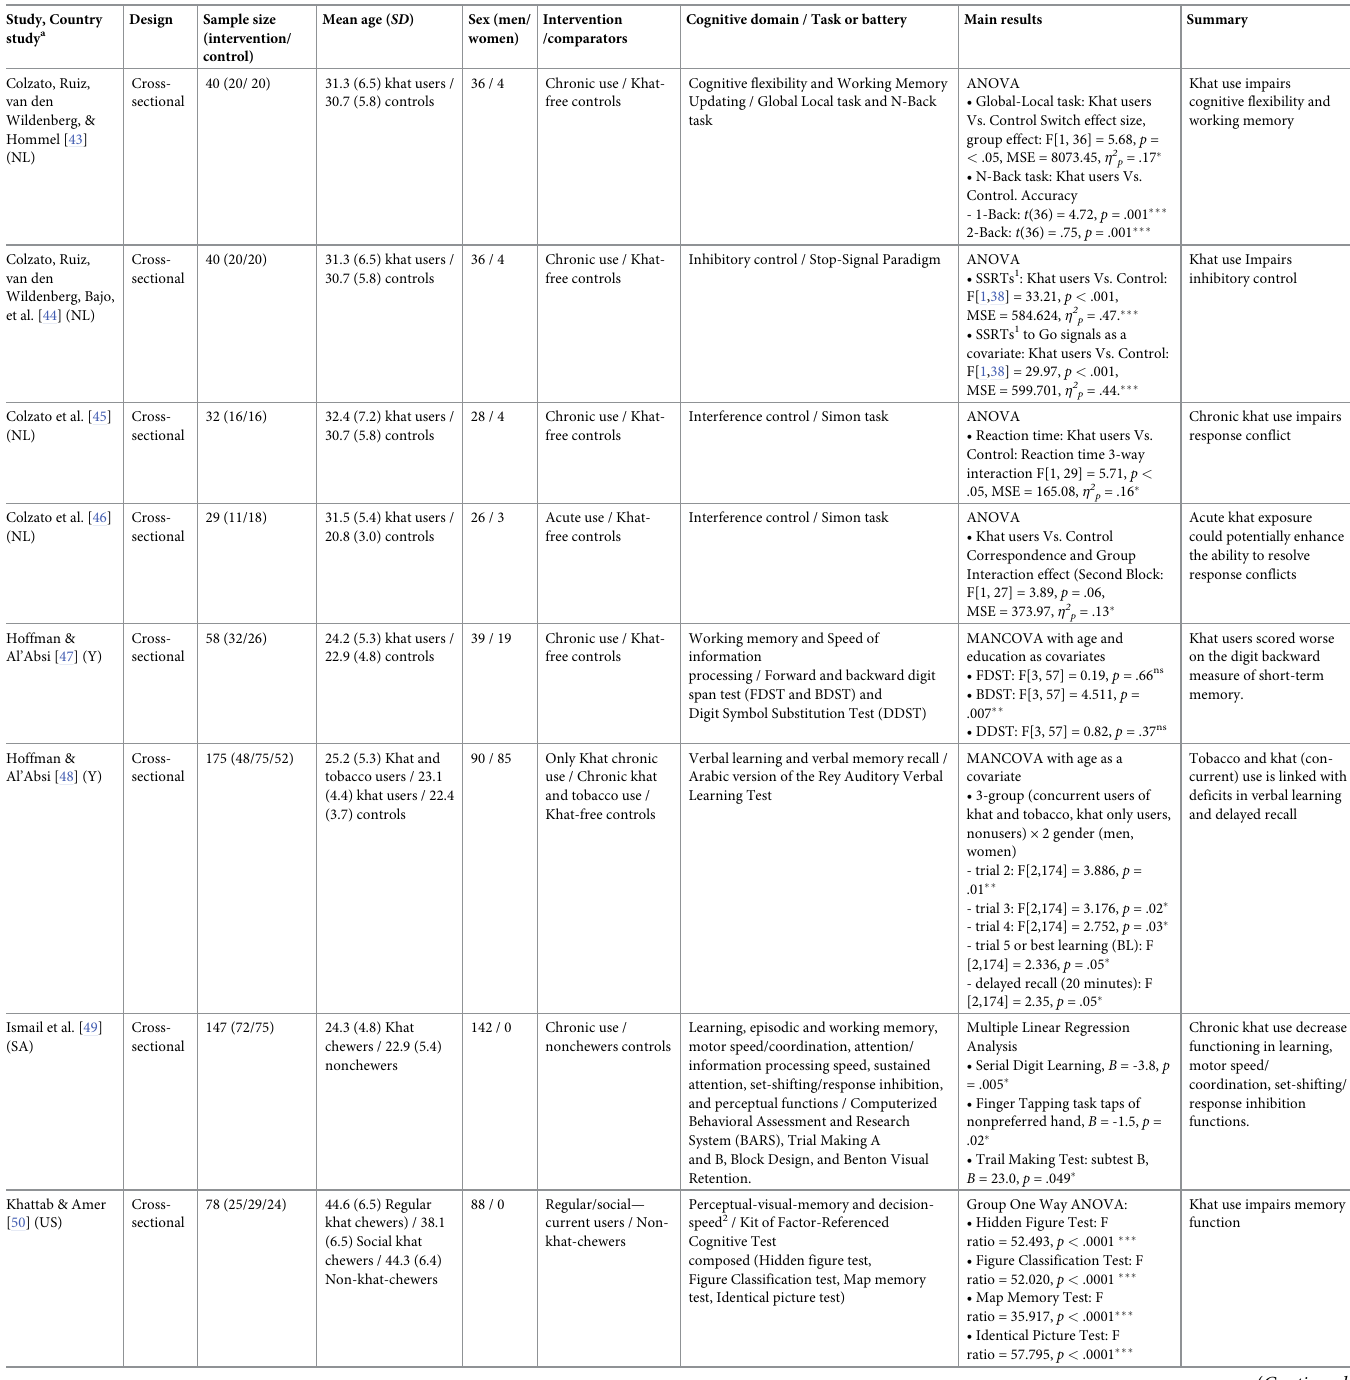
Table 2. Description of the human studies included in the present systematic